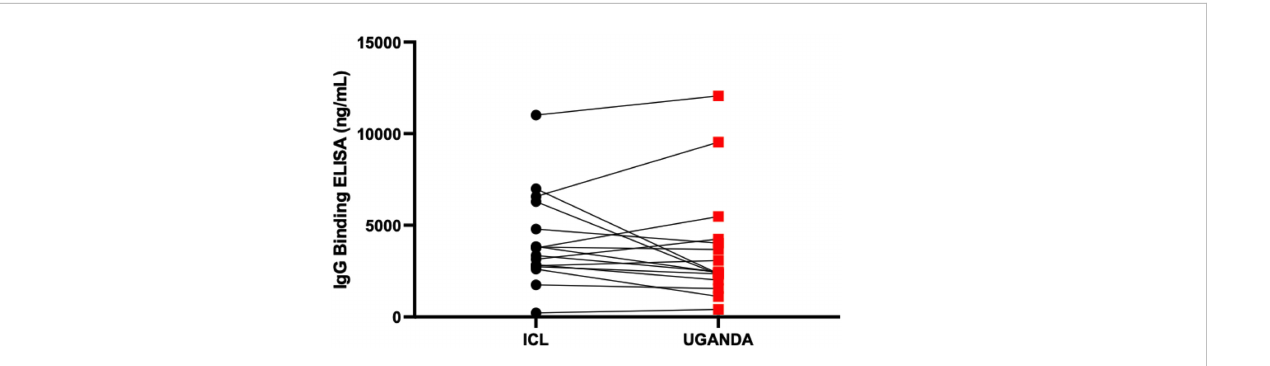
FIGURE 9 Inter-site cross-validation of the in-house ELISA. The fi gure compares antibody concentration concordance from use of the in-house ELISA to test the same specimens at Imperial College London and Uganda Virus Research Institute